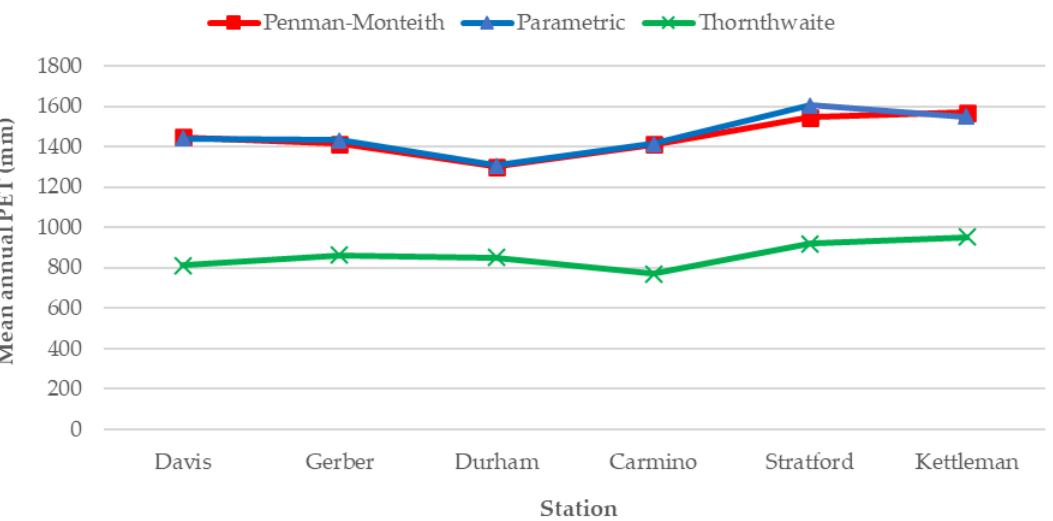
Figure 5. Mean annual Penman–Monteith PET against the parametric and Thornthwaite methods at each station.